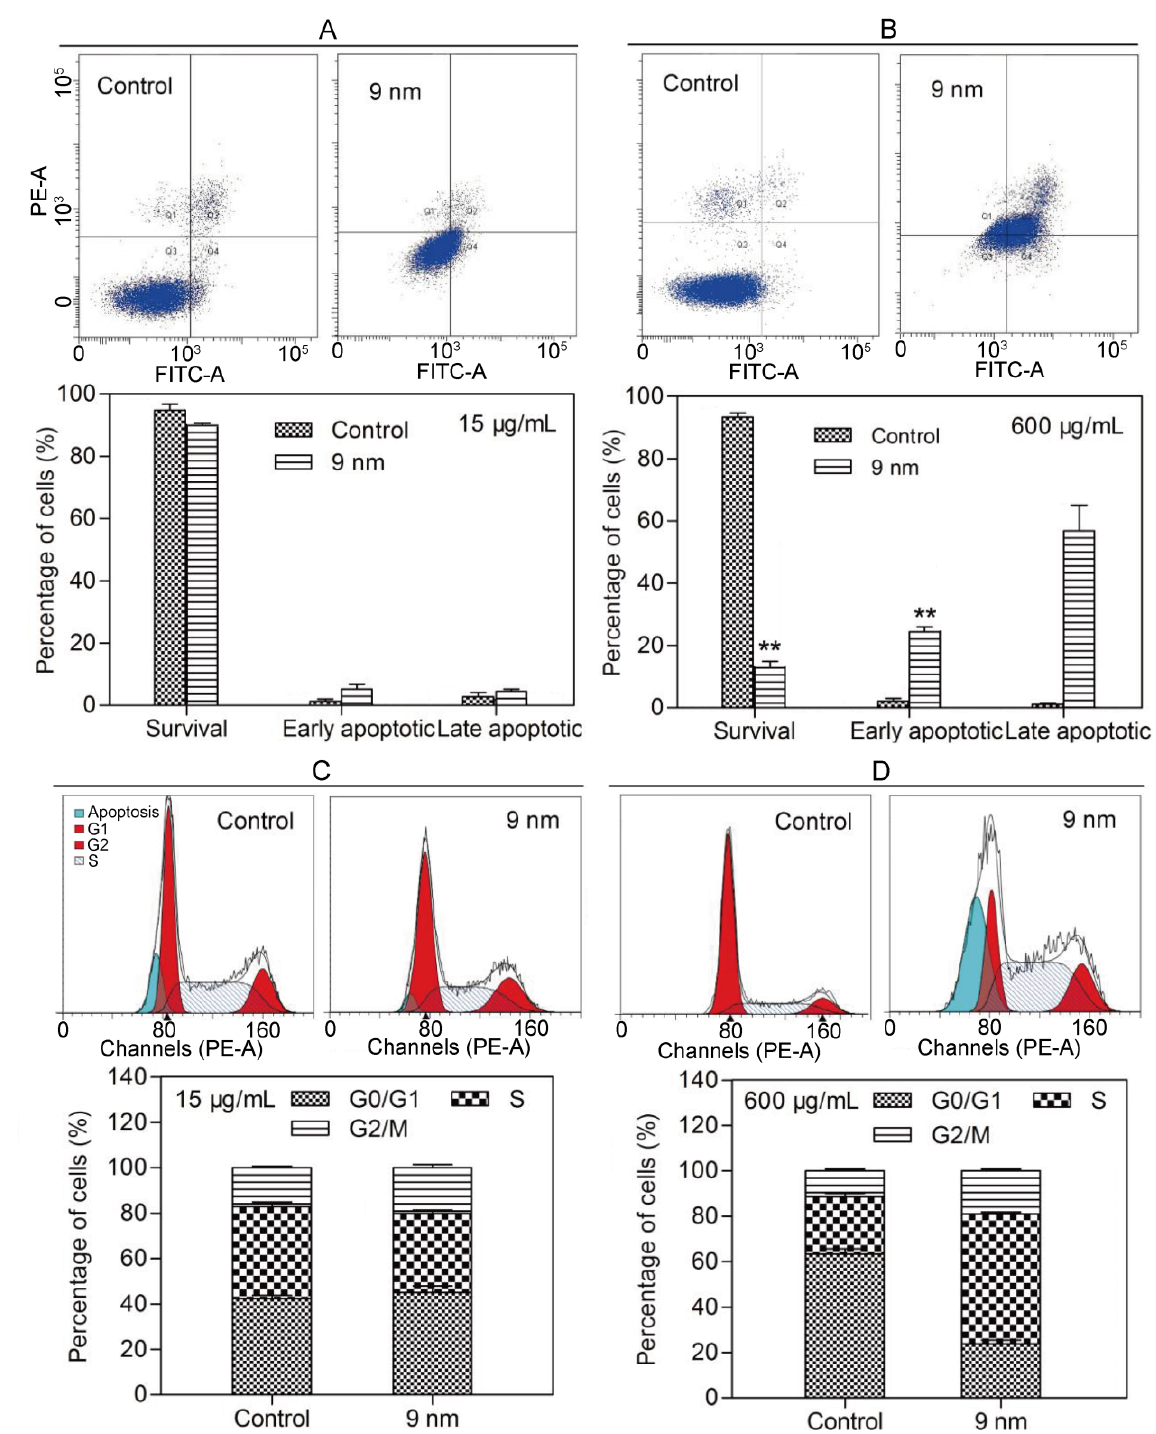
Figure 4: The analysis of cell apoptosis and cell cycle: Flow cytometer analysis on cell apoptosis of MCF-7 cells incubated with 9 nm Fe 3 O 4 NPs for 48 h at a concentration of 15 µ g/mL (A) and 600 µ g/mL (B). Flow cytometer analysis on cell cycle of MCF-7 cells with 9 nm Fe 3 O 4 NPs for 48 h at a concentration of 15 µ g/mL (C) and 600 µ g/mL (D). All histograms are quantitative figures for the corresponding cycle and apoptosis. Data are presented as mean ± S.D.